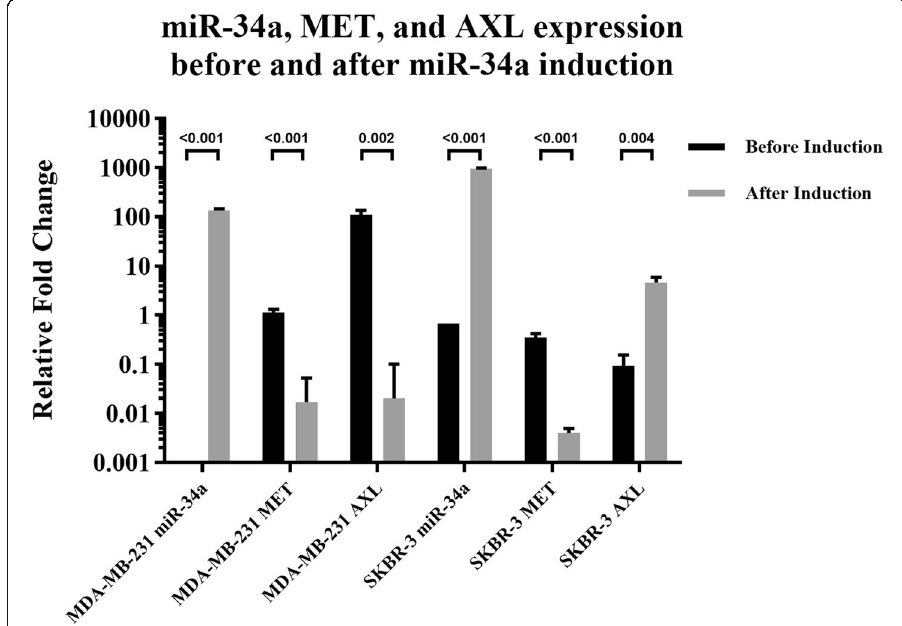
Fig. 6 Comparison of miR-34a, MET , and AXL expression before and after miR-34a induction in the cell